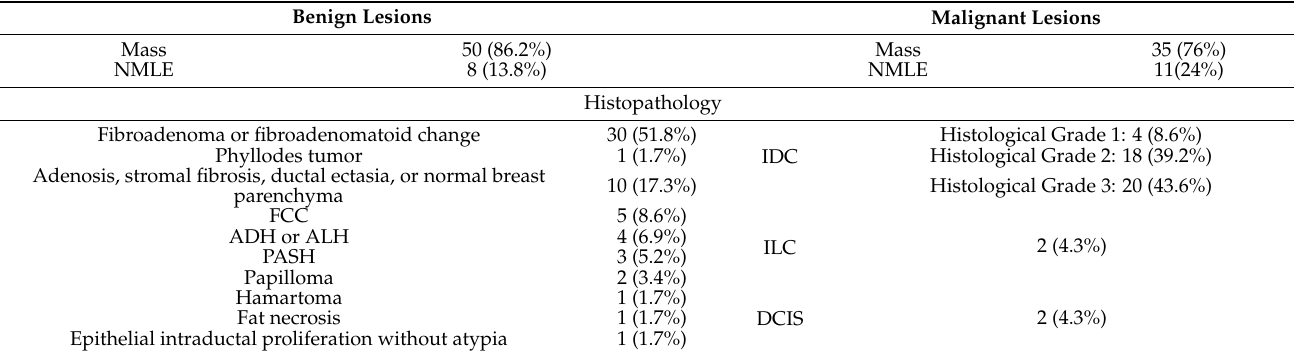
Table 2. Characteristics of the 104 lesions included in the